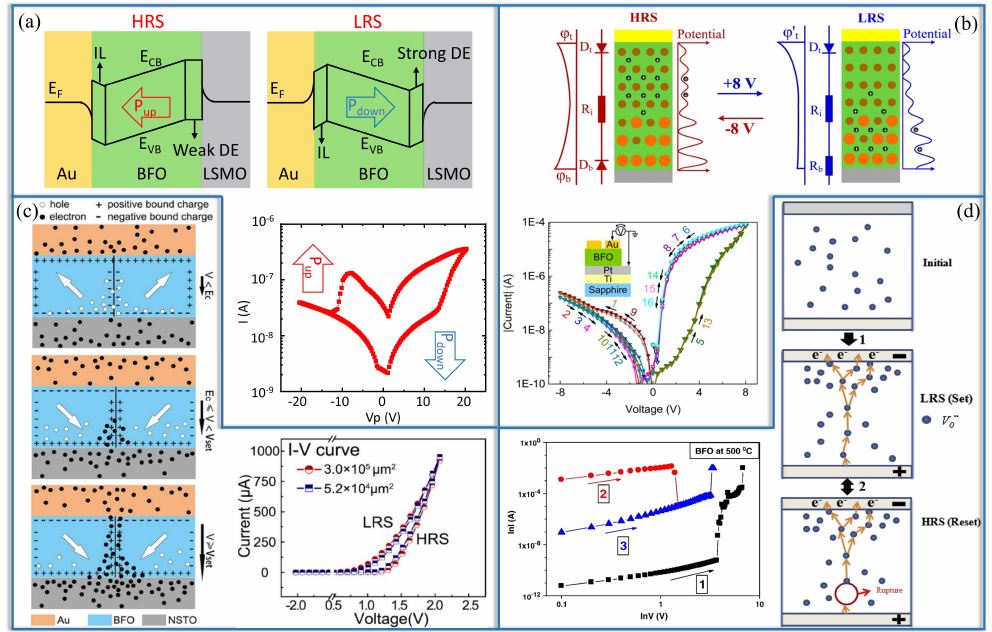
Figure 5. Schematic diagrams of RS mechanisms in memristive devices. ( a ) Multiferroelectric tunnel junction, adapted from Ref. [61], ( b ) Voltage-controlled metal-insulator interface RS, reproduced with permission from Ref. [11], ( c ) Ferroelectric domain wall, reproduced with permission from Ref. [21], and ( d ) Voltage-controlled filament RS, reproduced with permission from Ref. [62]. The switching IV curves are presented as a signature for